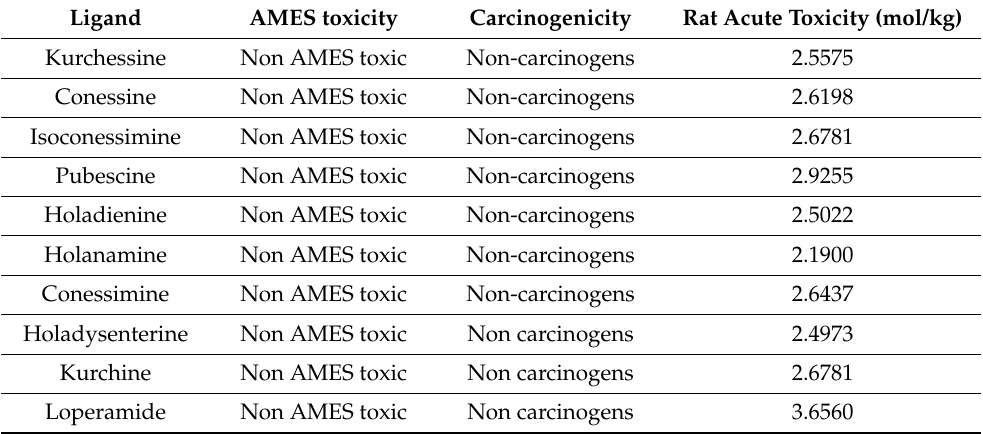
Table 6. ADMET Predicted Profile